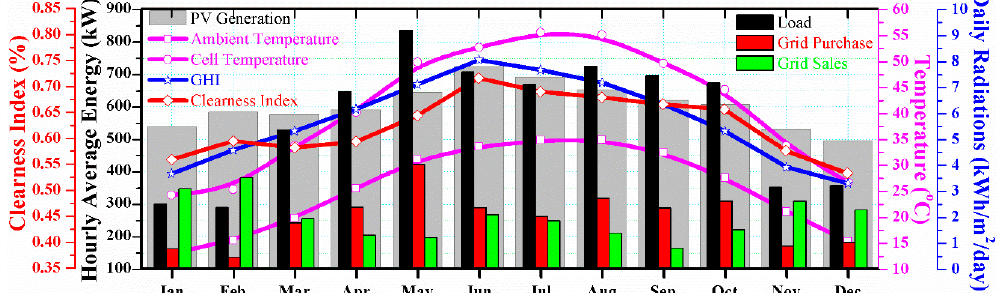
Figure 11. Hourly average PV energy generation, electrical load, grid sales, grid purchases, GHI, and temperature in a year.